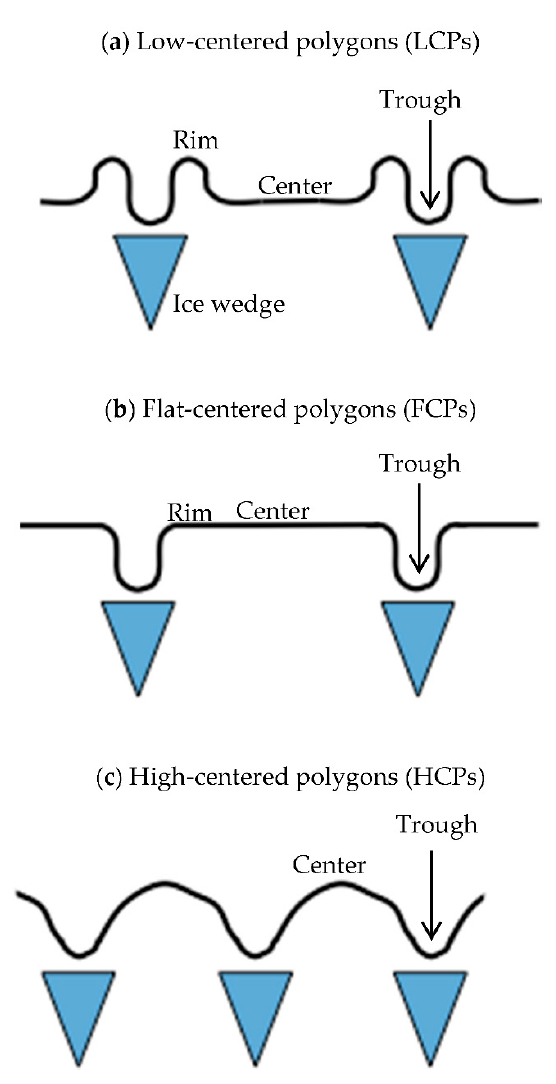
Figure 1. Schematic diagrams of different polygon types and polygon features (from Wainwright et al., 2015): ( a ) low-centered, ( b ) flat-centered and ( c ) high-centered polygons. In this study, we defined rims only when the polygon edges are higher than the centers.